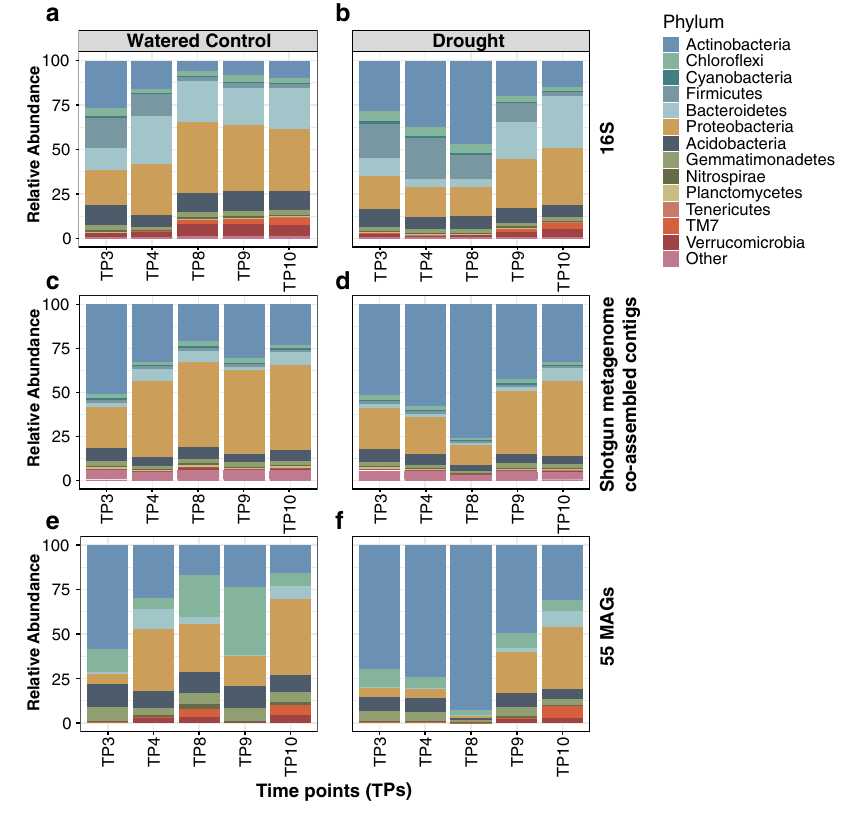
Fig. 1 Relative abundance pro fi les of microbial taxa in the sorghum rhizosphere under drought. Percent relative abundance ( y -axis) in the rhizosphere of the top 13 most abundant phyla for watered controls ( a , c , e ) and drought treatments ( b , d , f ) as measured by 16S rRNA gene amplicon sequencing ( a , b ), co-assembled contigs from shotgun metagenomic datasets ( c , d ), and all reads mapping to the 55 metagenome-assembled genomes (MAGs) ( e , f ). All fi ve time points (TP3 − TP10, shown on the x -axis) were selected based on the availability of data across all three data analysis types. All reads that mapped to other phyla or which were not classi fi able at the phylum level are grouped into a fourteenth category, entitled Other. TP: time